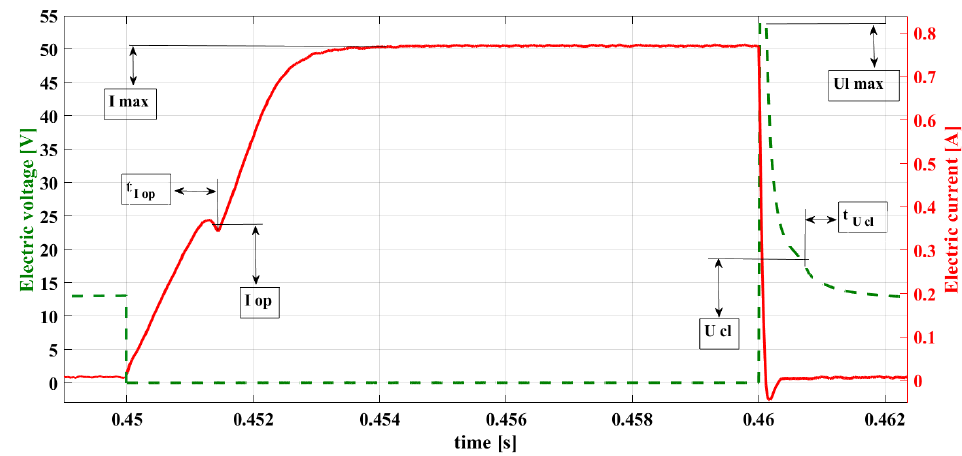
Figure 9. Characteristic points of a sample current waveform.